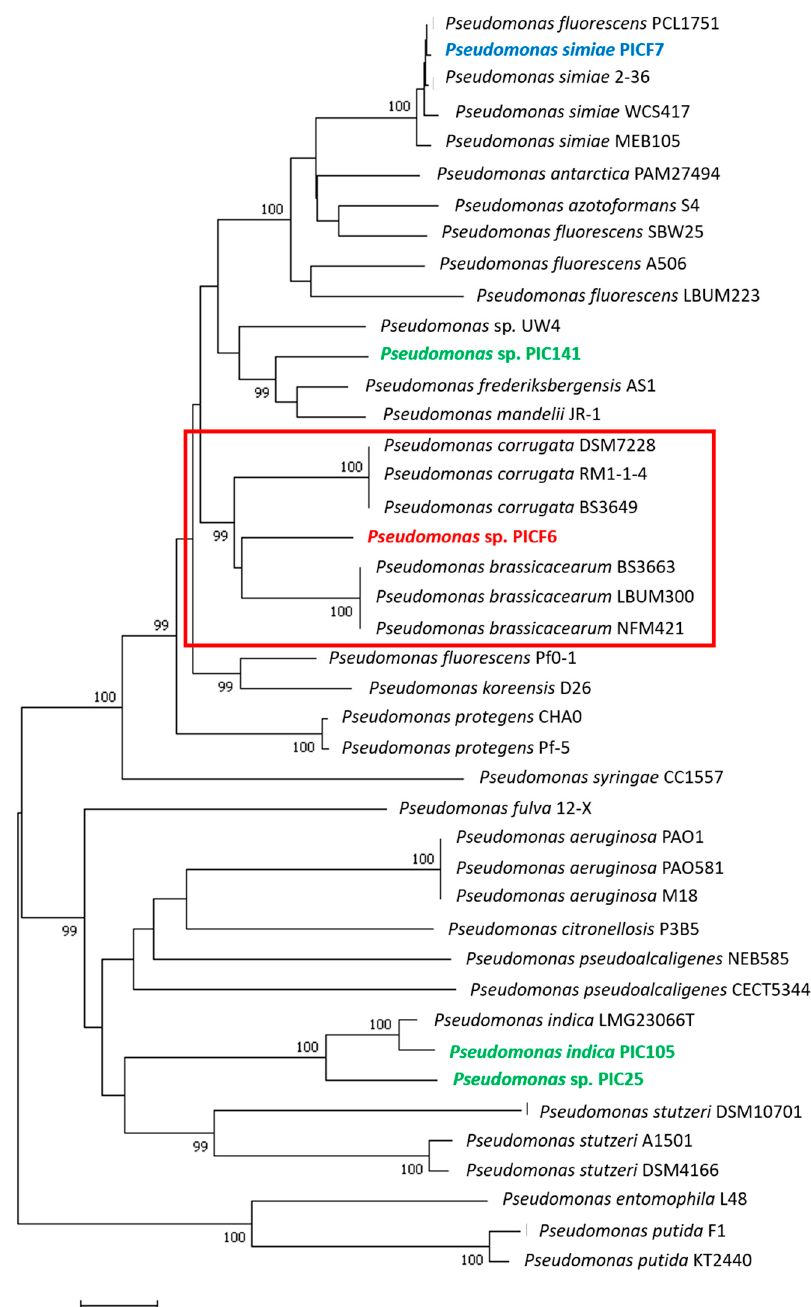
Figure 5. Neighbor ‐ Joining phylogenetic tree showing the taxonomic position of Pseudomonas sp. PICF6 (red text) based on the alignment of concatenated partial sequences of the housekeeping genes gyrB and rpoD genes (see text for details). Red rectangles highlight the two closest species to strain PICF6. Other olive rhizobacteria included in the analysis are indicated in blue ( Pseudomonas simiae PICF7) or green ( Pseudomonas indica PIC105 and Pseudomonas spp. 25 and 141) (Supplementary Table S1). Bar indicates sequence divergence (nt). Only bootstrap values ≥ 95%, based on 1000 re ‐ sampled datasets, are shown at branch nodes.